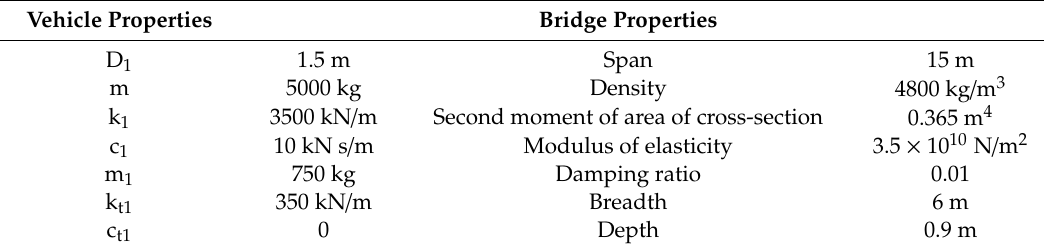
Figure 2. Bridge and vehicle model. Table 1. Properties of vehicle and bridge models.